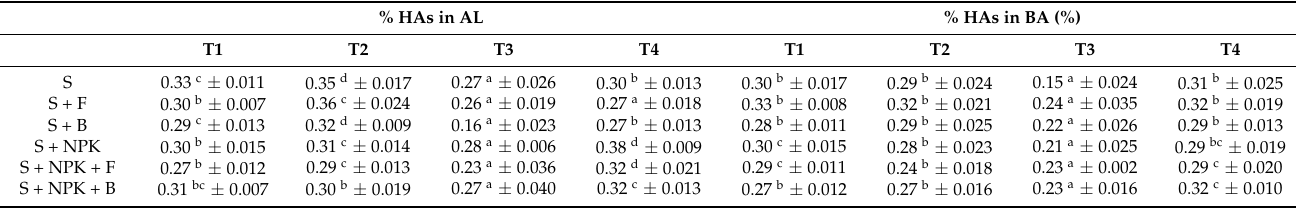
S—soil without additives, S + F—soil with fungal strains, S + B—soil with bacterial strains, S + NPK—soil with NPK, S + NPK + F—soil with fungal strains and NPK, S + NPK + B—soil with bacterial strains and